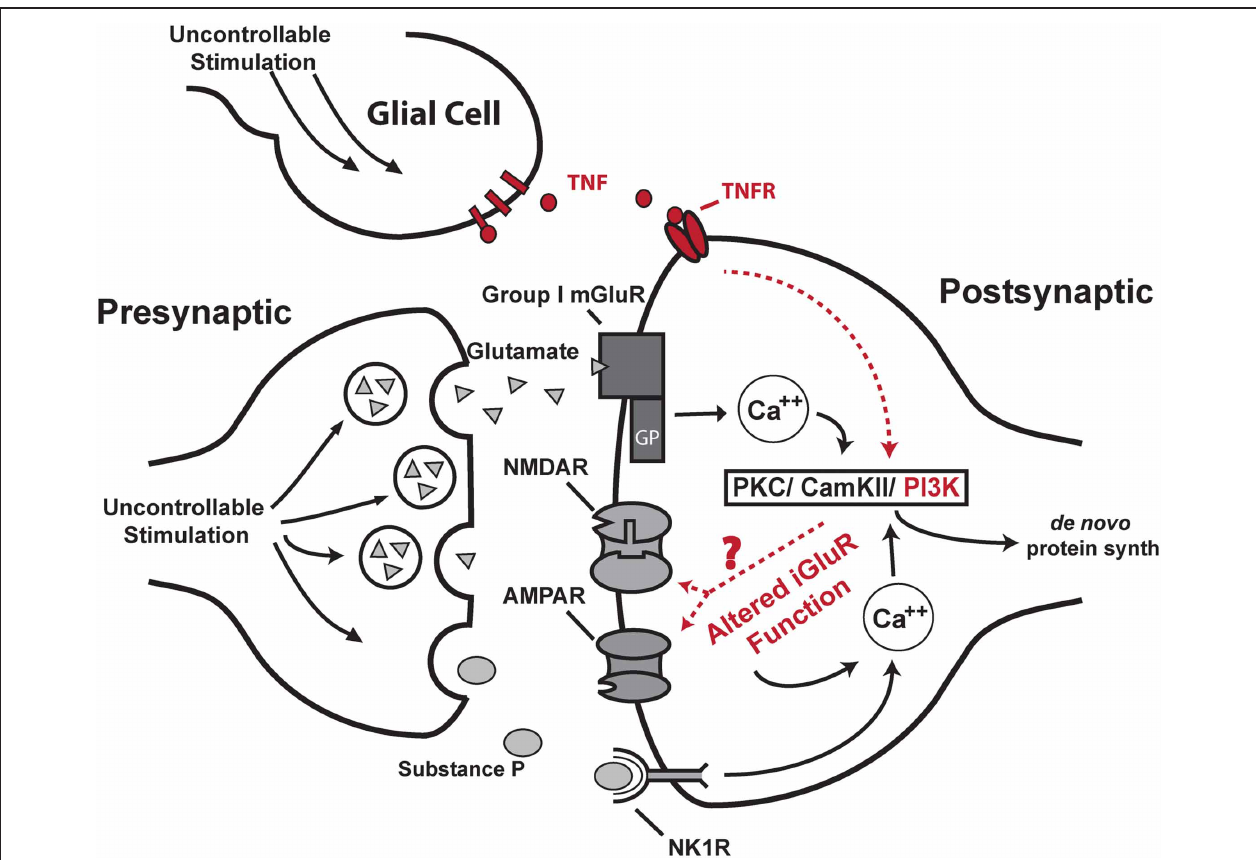
lines). Altered iGluR activation is known to further increase post-synaptic calcium levels through the NMDA receptor channel and calcium-permeable AMPA receptors, which may provide a mechanism for altered associative learning in the spinal cord. Increases in intracellular calcium can induce further protein kinase activity and de novo protein synthesis, all of which have all been shown necessary for the development of the stimulation-induced spinal learning deficit (Patton et al., 2004; Baumbauer et al., 2006; Huie et al., 2012a). Well-characterized features are shown in black. Areas of ongoing study are shown in red. Adapted from Ferguson et al.